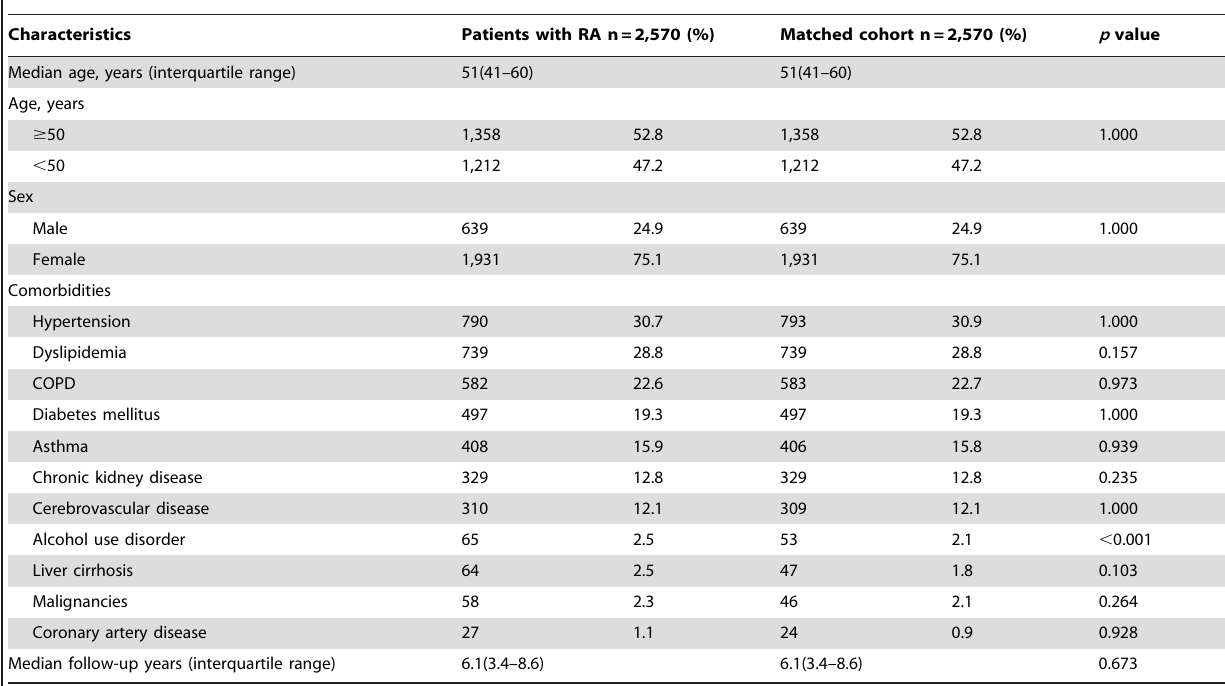
Table 1. Baseline characteristics of patients with rheumatoid arthritis (RA) and the matched cohort.